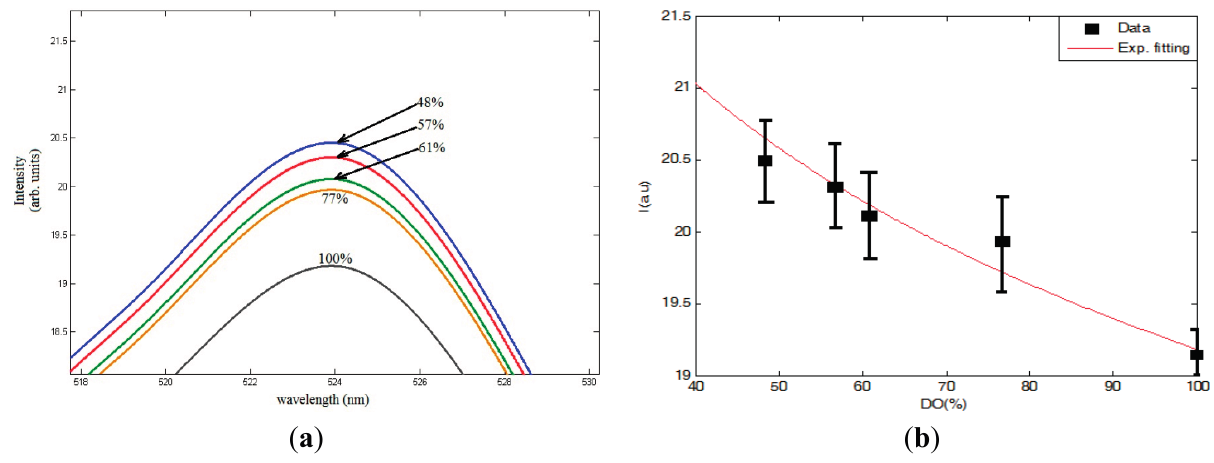
Figure 6. ( a ) Visible flouresence spectra at different DO concentration; and ( b ) Fluorescence peak intensity variation with fitting.